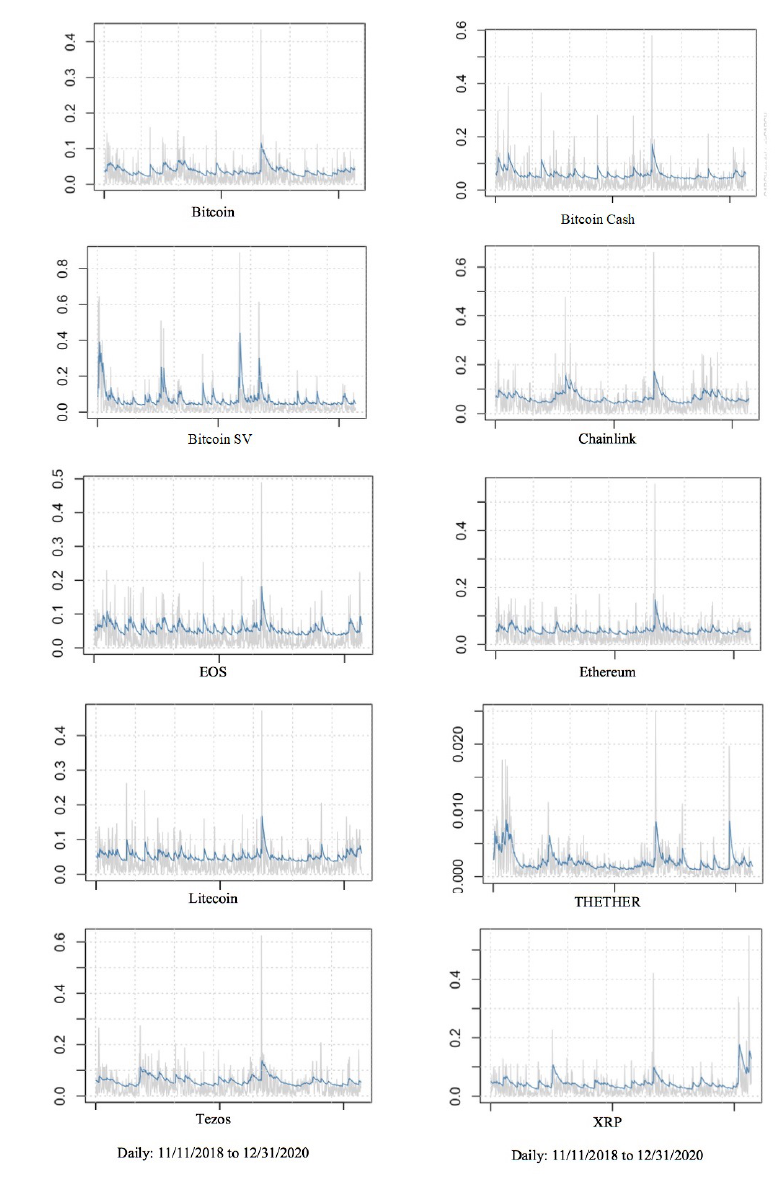
Figure 6. Volatility prediction by conditional variance (vs. absolute value of returns) using GJR- GARCH